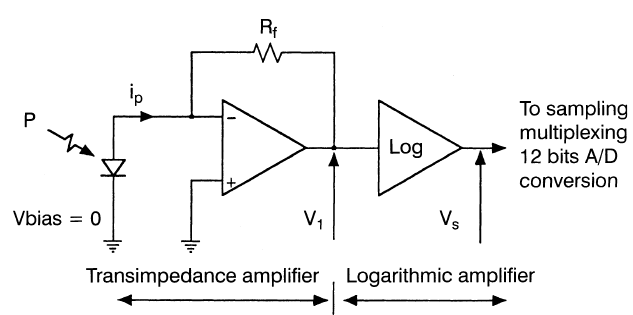
Fig. 6. Photodiode amplifier